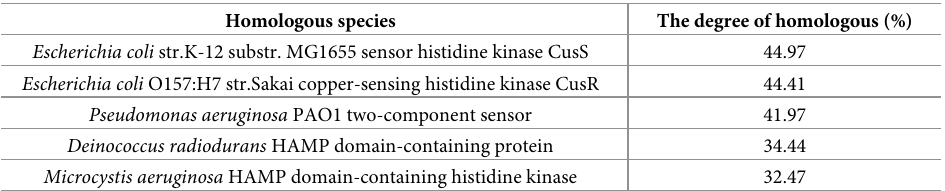
Table 2. Protein sequence homology alignment